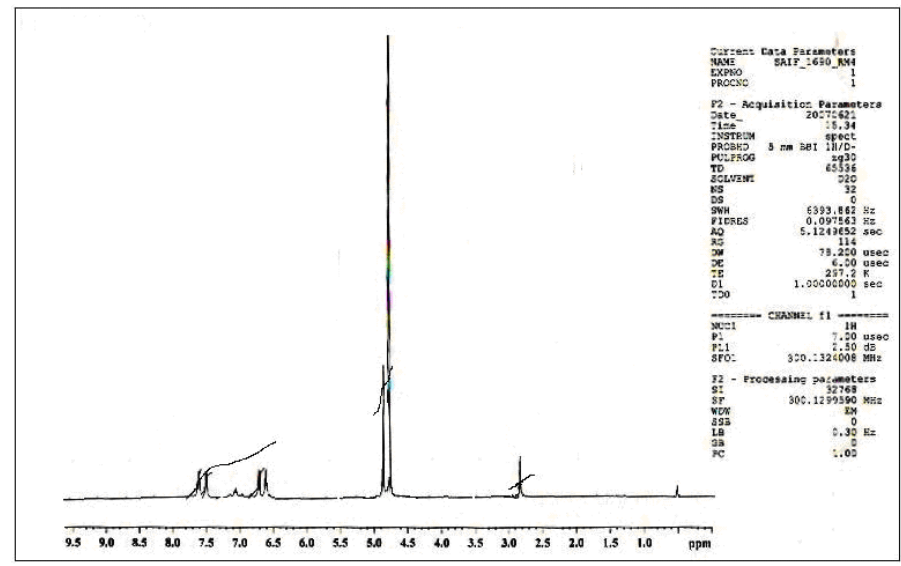
Figure 2. 1 H-NMR spectra of cuprous